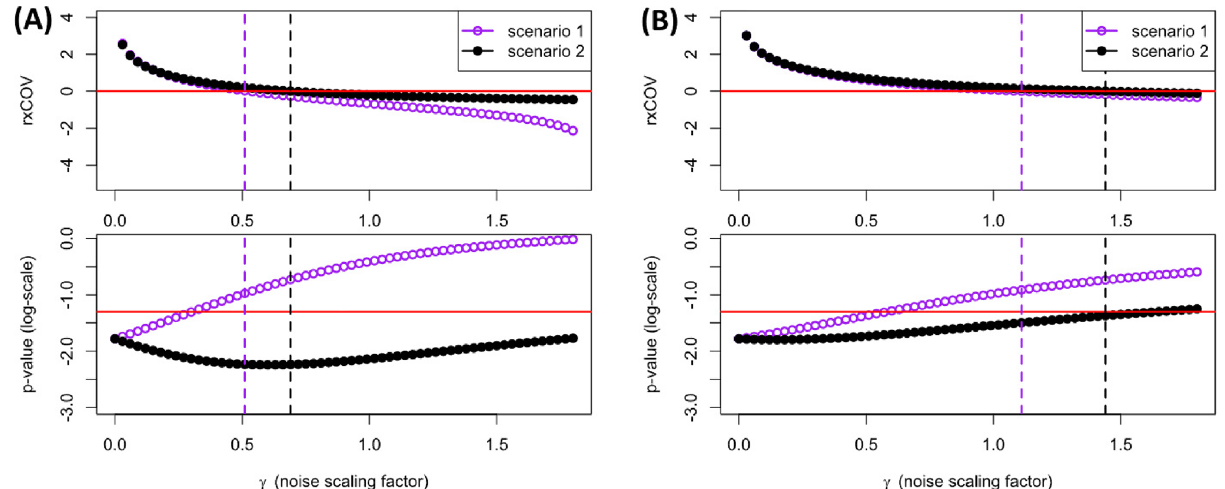
Figure 2. Simulated example of rx COV identifying spurious statistical significance and capturing effect of experimental replication. ( A ) Fig. 1D is extended to include the relation between rx COV and p-value as a function of γ for the two noise scenarios presented in Fig. 1B,C. The solid red line in the p-value plot (bottom panel) indicates p-value of 0.05. The dashed vertical lines corresponding to the two scenarios continue over from the top panel and correspond to the value of γ where rx COV reaches zero. They establish the noise level beyond which p-value based computational of statistical significance becomes spurious. ( B ) Three replicates of s X and s Y are generated from the same distribution used in Fig. 1A. Corresponding values of d X and d Y are computed and averaged to increase analyte SNR. The rightward shift of the purple and black dashed vertical lines coupled with the convergence of the rx COV plots for the two scenarios demonstrates the ability of rx COV to capture the increased SNR due to data